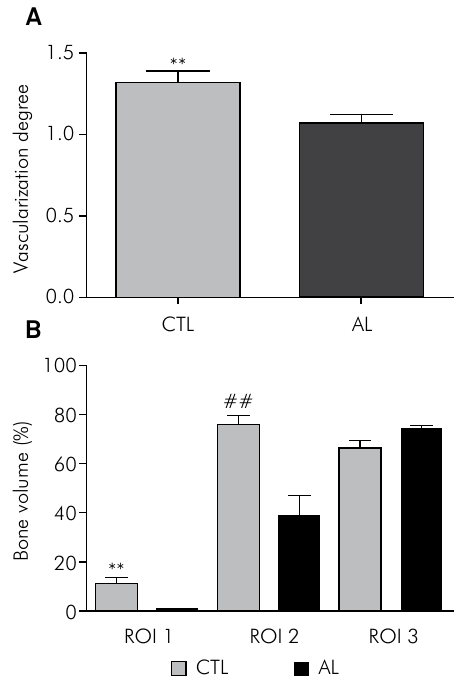
Figure 4. The effects of ALN therapy on the degree of vascularization and bone volume (%) in experimental groups 28 days after tooth extractions. (A) Animals of the CTL group developed a higher degree of vascularization compared with those treated with ALN (**p < 0.01). (B) Regions of Interest (ROI) 1 and 2 of CTL animals exhibited a statistically significant increase in bone volume compared with ROIs 1 and 2 of animals treated with ALN (**p < 0.01 in relation to ROI 1 of AL; ##p < 0.01 in relation to ROI 2 of